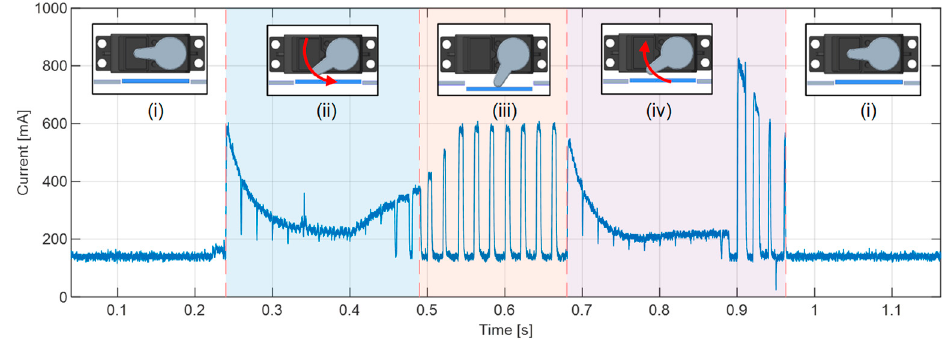
Figure 13. Instantaneous current consumption by the IoT device during a button press. Servomotor cyclic states: (i) idle, (ii) activation, (iii) button pressed, and (iv) deactivation.